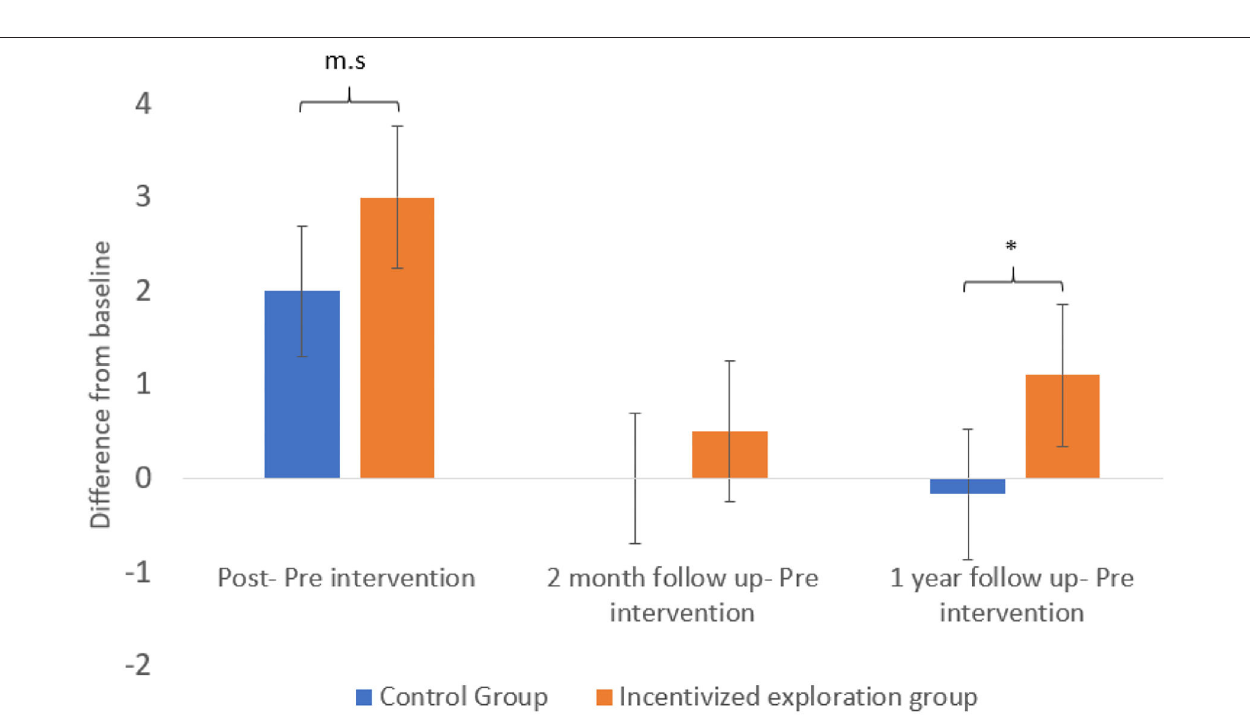
FIGURE 2 | Between groups comparison of the difference between the number of salads eaten pre-intervention and post intervention, 2 months follow up and 1 year follow uptime points. * p < 0.05, 0.051 < m.s <